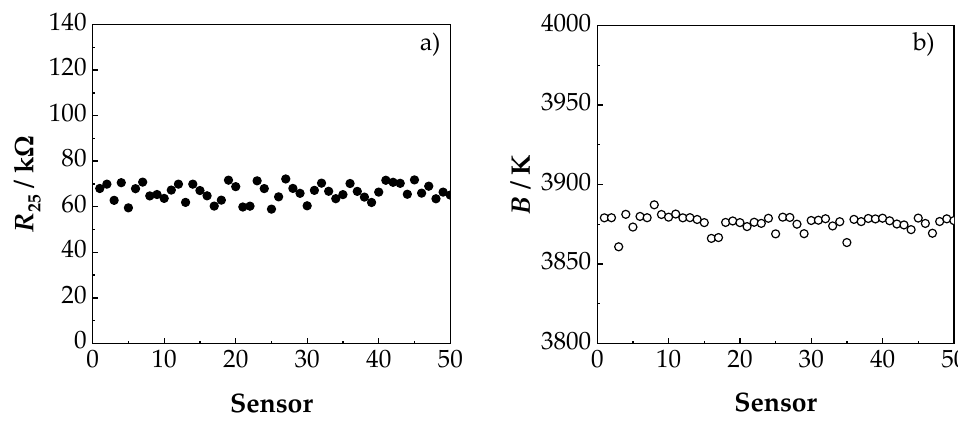
Figure 8. Determined ( a ) R 25 value and ( b ) B values of 50 sensors.